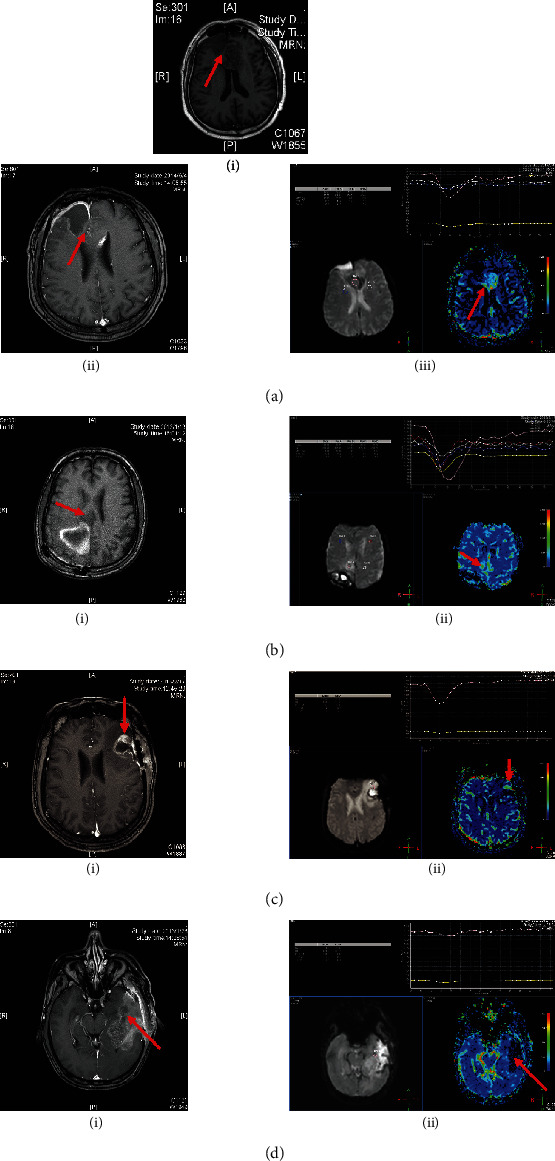
CE-MRI and PWI of the postoperative HGG patient before radiotherapy. (a). CE-MRI and PWI images for a 60-year-old male patient who had double frontal astrocytoma (WHO Grade III). The PWI showed high rCBV of 1.86 in the surgical cavity (iii), while no nonuniform contrast enhancement was found in the same region in the T1 axial image (i) and CE-MRI axial image (ii). (b). CE-MRI and PWI images for a 64-year-old male patient who had the right fronto-parietal glioblastoma (WHO Grade IV). The PWI showed high rCBV of 1.62 in the non-surgical area (ii), but the CE-MRI axial image did not illustrate contrast enhancement (i). (c). CE-MRI and PWI images for a 40-year-old male patient who had left frontal glioma (WHO Grade IV). CE-MRI, nonuniform contrast enhancement in the surgical cavity (i), and PWI shows high rCBV of 2.99 (ii). (d). CE-MRI and PWI images for a 63-year-old male patient who had left parieto-temporal lobe glioblastoma (WHO Grade IV). CE-MRI, nonuniform contrast enhancement in the surgical cavity (i), and PWI shows rCBV is normal (ii).